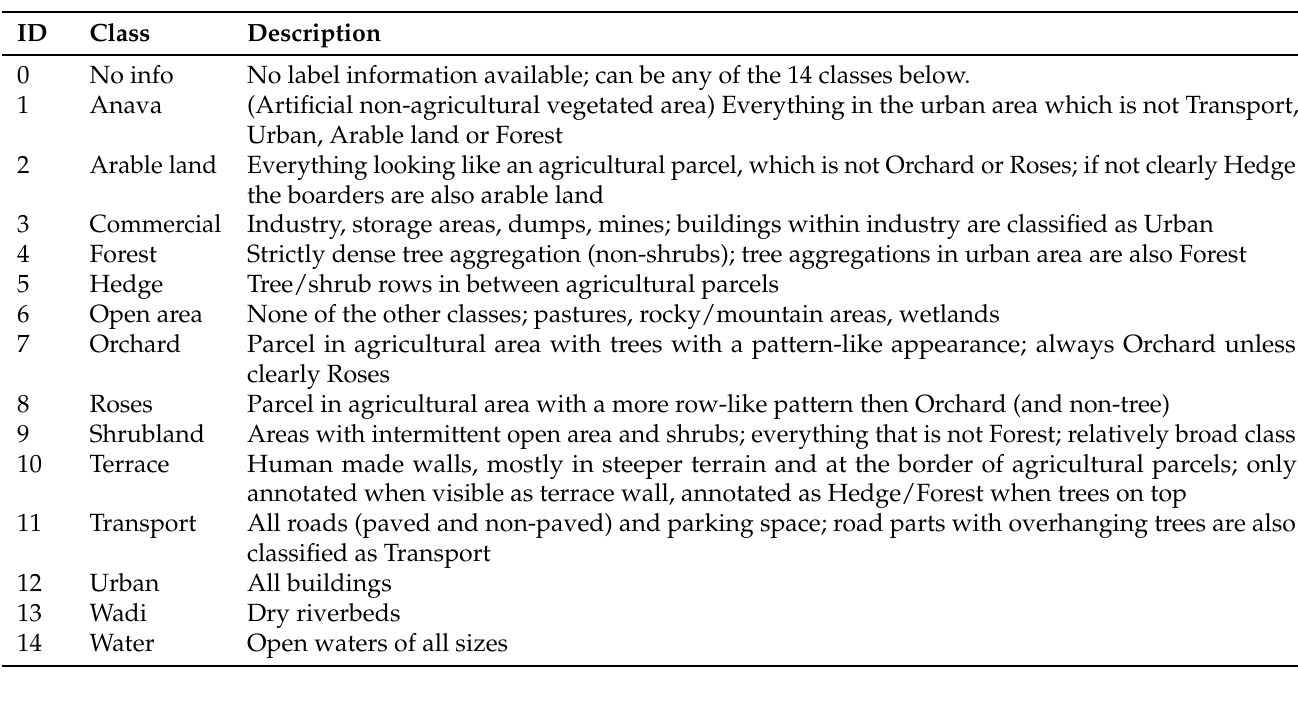
Table 3. Overview and description of the 14 identified land cover classes in the Sagalassos dataset.